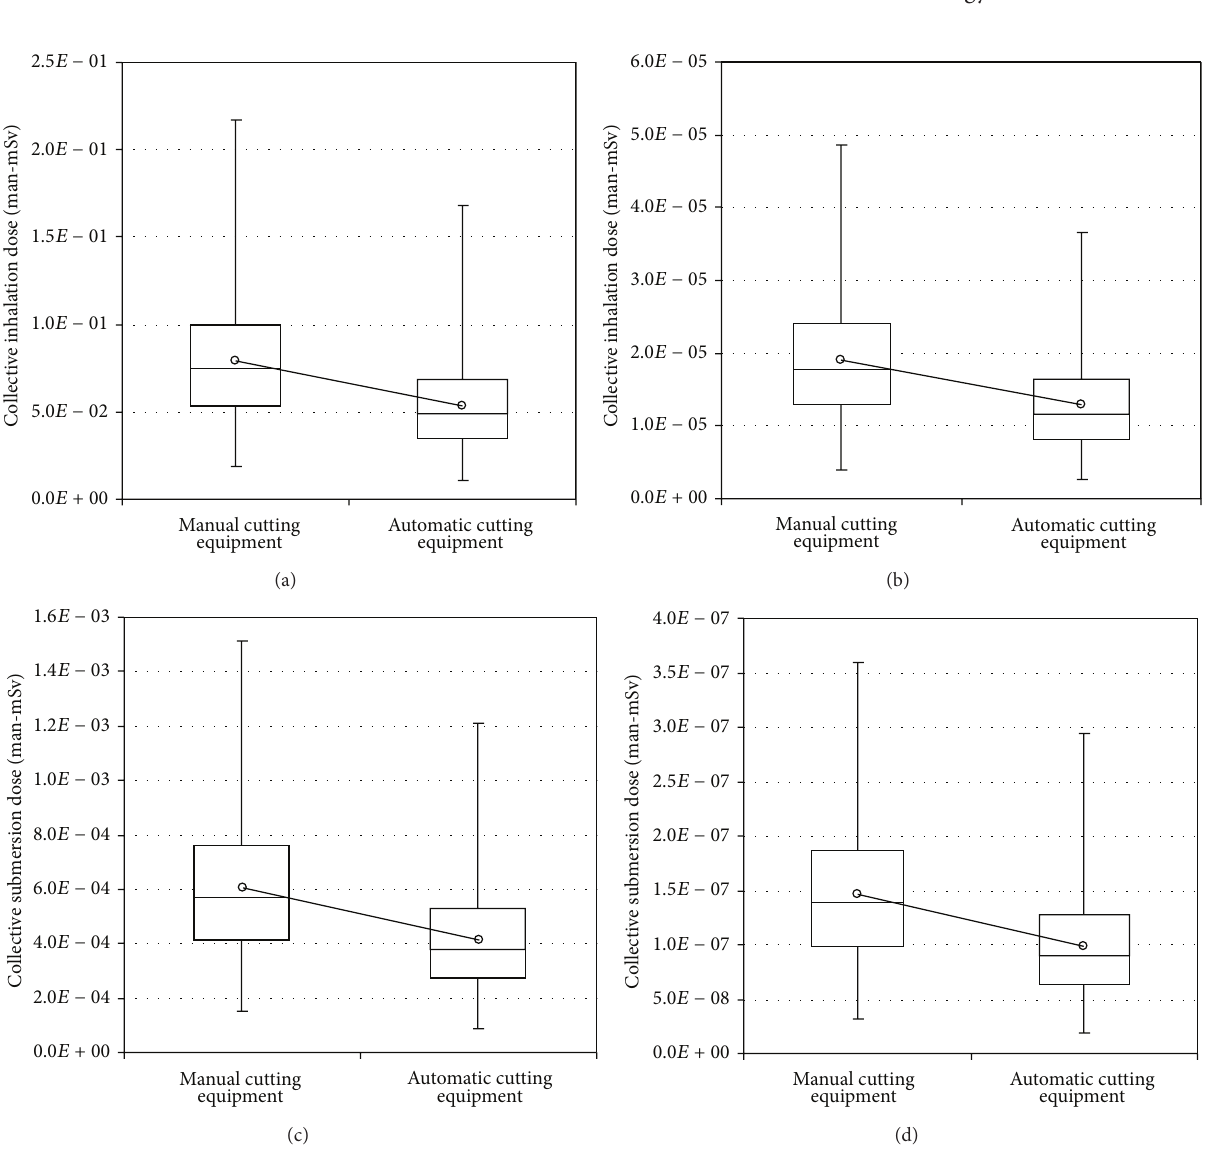
Figure 6: Whisker diagrams (ends of whiskers present minimum and maximum values; circles present average). (a) Collective inhalation doses using building exhaust ventilation, (b) collective inhalation doses using MFU, (c) collective submersion doses using building exhaust ventilation, and (d) collective submersion dose using